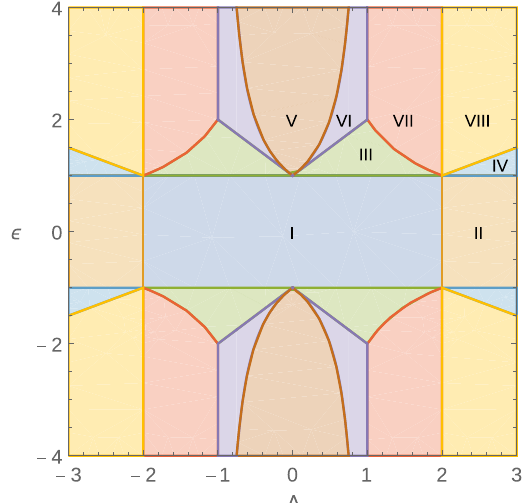
FIG. 8. Level curves for which the quantum value equals the classical bound. Note the different behavior depending on the parity of n= 2 and the effect of the different regions plotted in Fig. 7, also sketched here in gray (for odd n= 2 ) and black (even n= 2 ) for clarity. The region for which there is quantum violation is the bounded set [i.e., containing the point ð Δ ; ϵ Þ ¼ ð 1 ; 1 Þ ]. The plot is symmetric with respect to the line ϵ ¼ 0